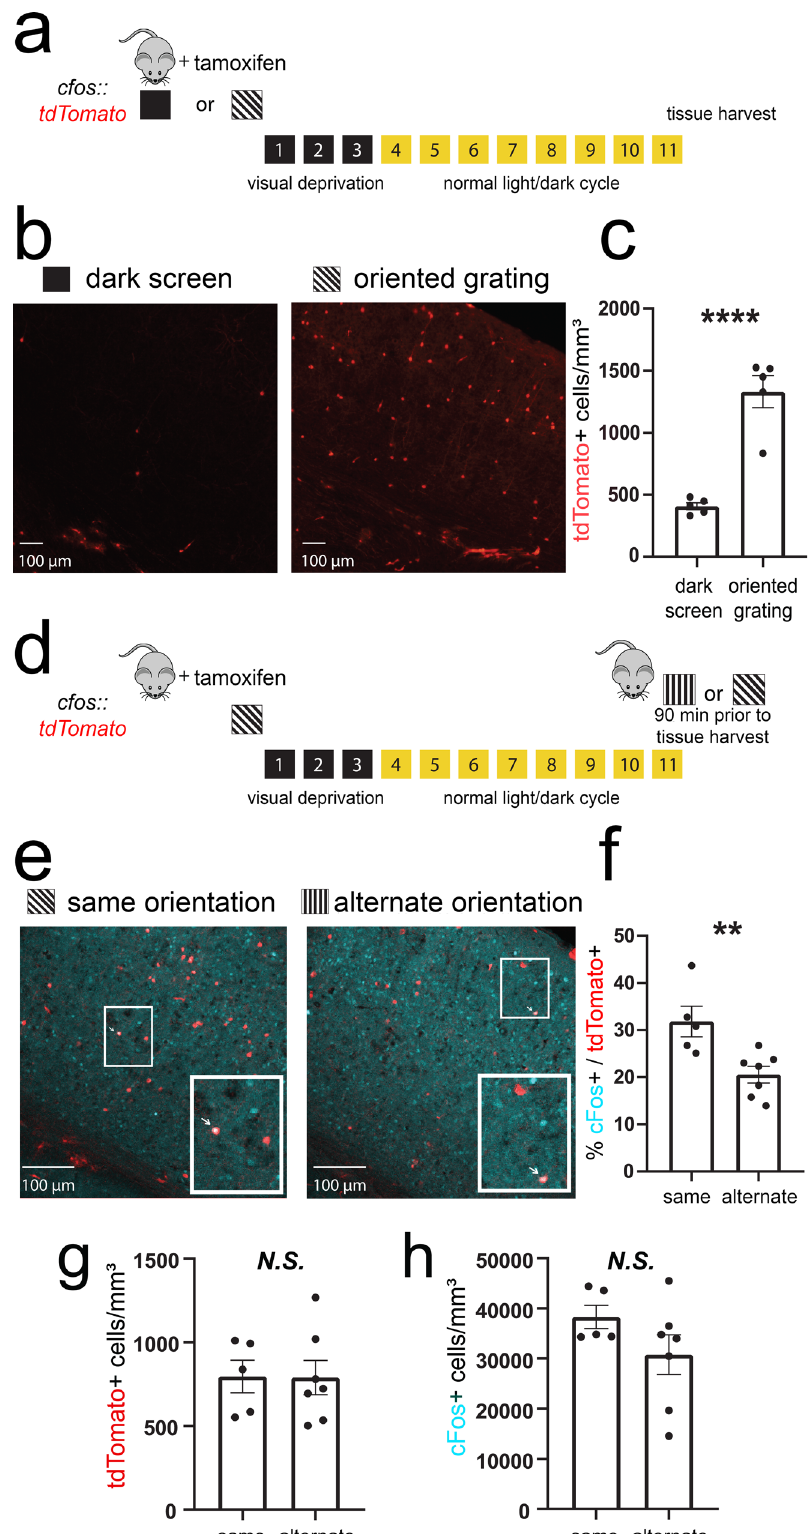
Rhythmic of fl ine reactivation of orientation-selective V1 ensembles induces plasticity and alters representation of orientation in V1 . To test whether sleep-associated reactivation of orientation-selective neurons could impact the representation of orientation across V1, we tested how rhythmic optogenetic activation of X °-activated TRAPed neurons affected surrounding